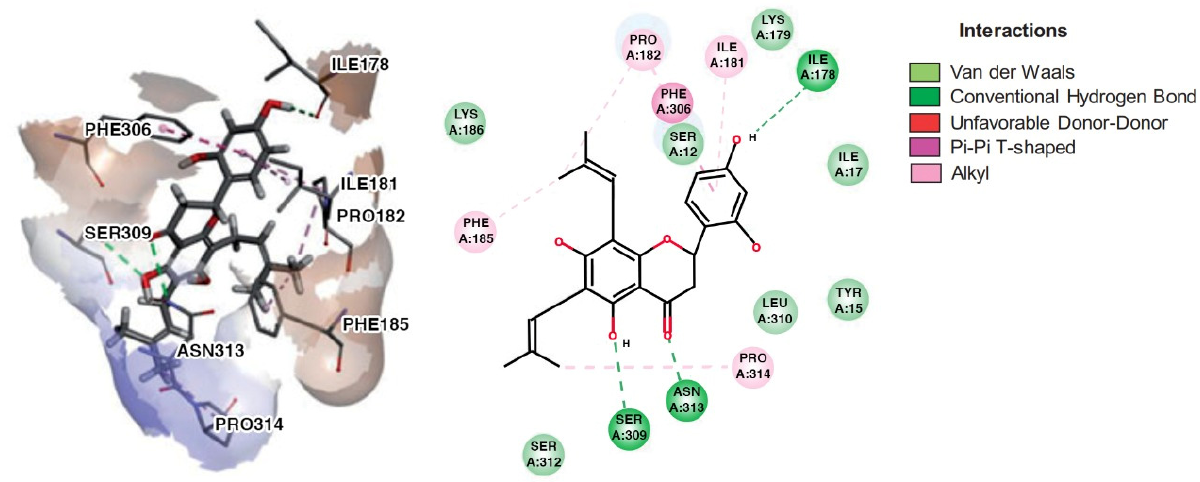
Figure 10. Kwon’s docking model of Kushenol E—IDO1 complex [24].